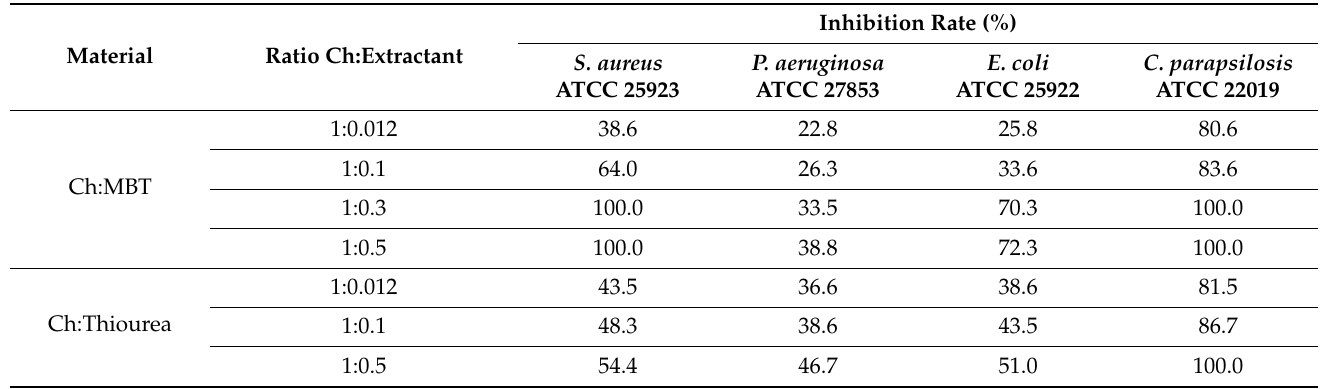
Table 7. Inhibition rate of bacterial and fungal growth when using sulfur materials.